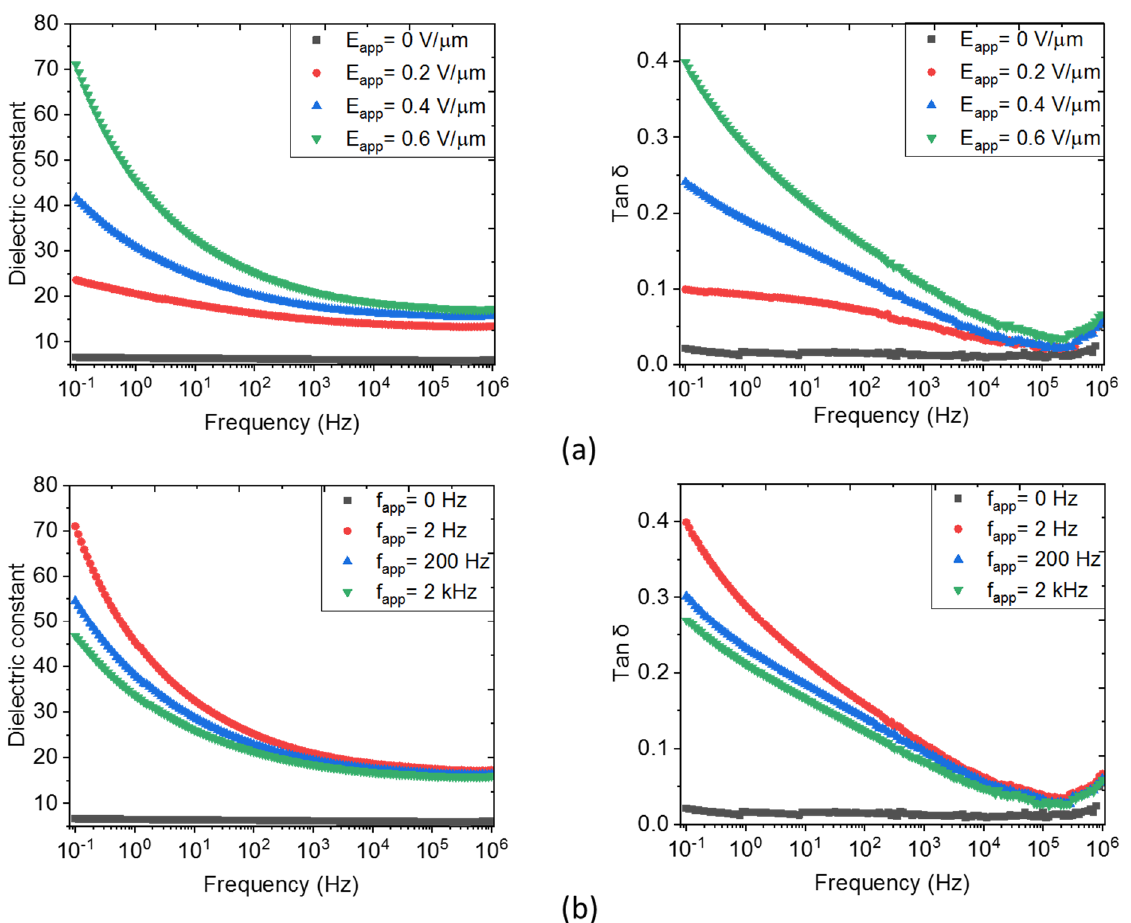
Figure 6. Broadband spectroscopy of an 8% vol. ZnO MRs composite under different parameters of the applied electric field: ( a ) Varied amplitude and fixed frequency of 2 Hz; and ( b ) Varied frequency and fixed amplitude of 0.6 V/µm.